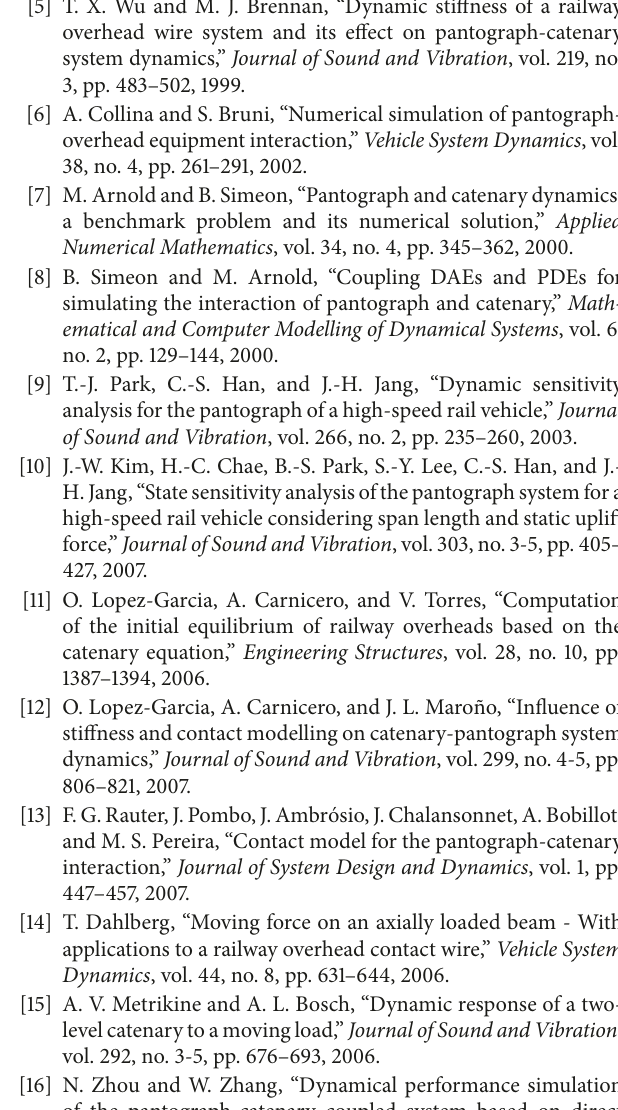
Figure 19: The slackening of the droppers in the elastic stitched catenary when (a) 𝑉 = 300 km/h and (b) 𝑉 = 350 km/h.